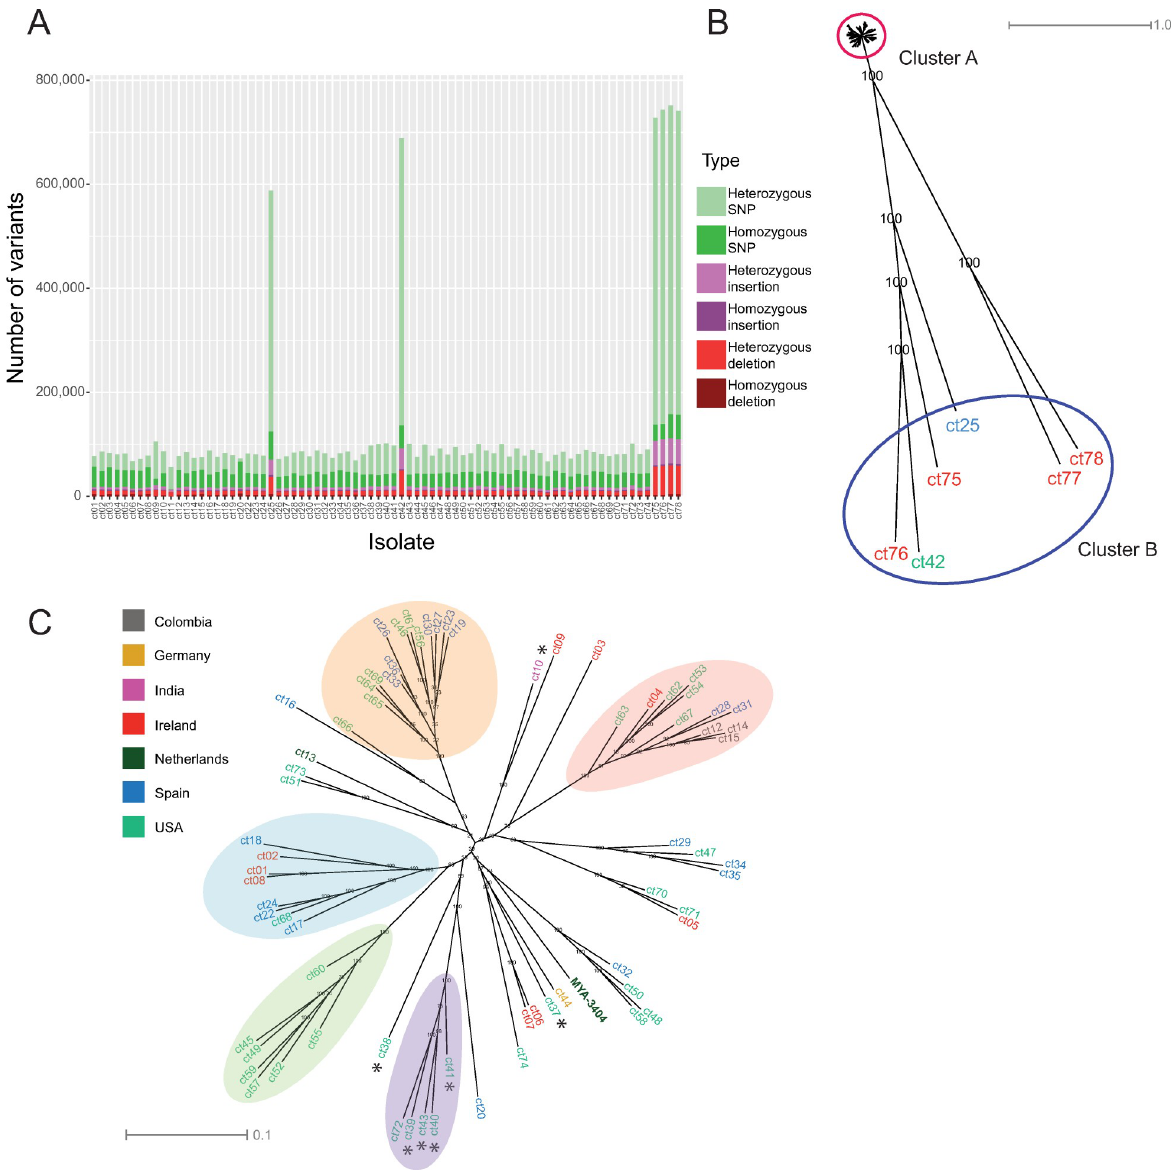
Fig 1. Identification of novel isolates of C . tropicalis . (A) Genome variation among C . tropicalis isolates. Variants were identified using the Genome Analysis Toolkit HaplotypeCaller and filtered based on genotype quality (GQ) scores and read depth (DP). Variants for all 77 isolates are shown according to variant type. Isolates are labelled on the X-axis by strain ID. One isolate ( C . tropicalis ct20) has mostly homozygous variants, and six isolates have very high levels of heterozygous variants. (B) Six isolates of C . tropicalis are highly divergent. Variants were called as in (A). For heterozygous SNPs, a single allele was randomly chosen using RRHS [93] and for homozygous SNPs, the alternate allele to the reference was chosen by default. This process was repeated 100 times and 100 SNP trees were drawn with RAxML using the GTRGAMMA model [94]. The best- scoring maximum likelihood tree was chosen as a reference tree and the remaining 99 trees were used as pseudo-bootstrap trees to generate a supertree. Pseudo-bootstrap values are shown as branch labels. The six divergent isolates (Cluster B) are labelled according to their country of origin (see 1C). (C) SNP phylogeny of isolates from Cluster A indicates that clade structure is not associated with geography . The phylogeny of cluster A is shown in detail. Pseudo-bootstrap values are shown as branch labels. Isolates are labelled according to their country of origin, and environmental isolates are indicated with an asterisk. The reference strain, C . tropicalis MYA-3404, is labelled. Five putative clades are highlighted with colored bubbles. These clades are supported by principal component analysis (PCA) (S3 Fig). A sixth group was also identified by PCA, encompassing the remainder of isolates in the tree (S3